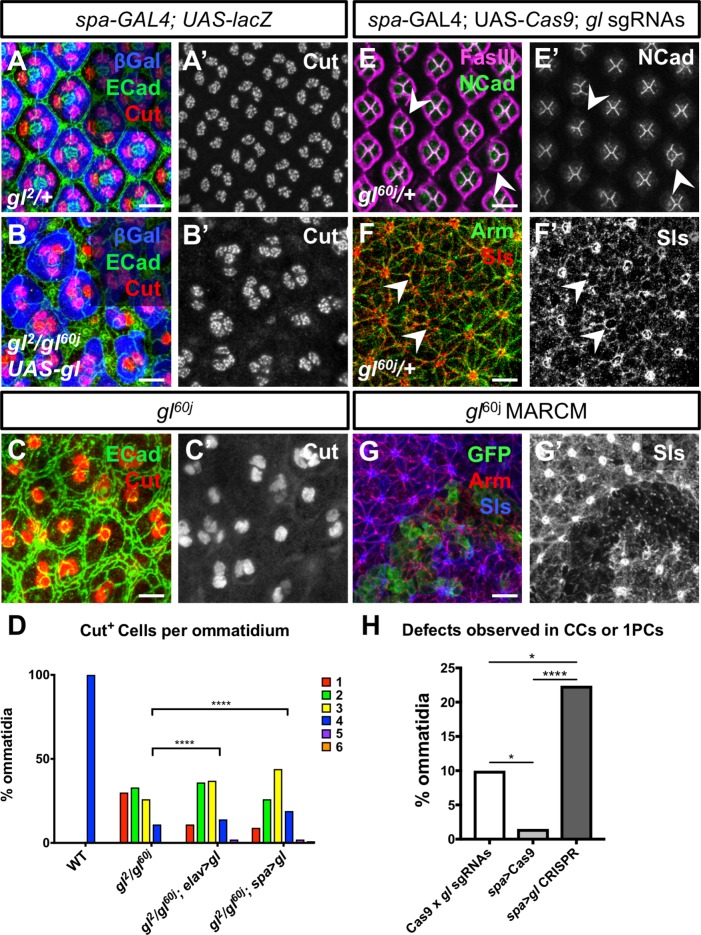
Gl can act autonomously in cone cells.(A-C) 42h APF pupal retinas stained with anti-Ecad (green), anti-Cut (A’-C’, red in A-C) and anti-β-galactosidase reflecting UAS-lacZ driven by spa-GAL4 (blue in A, B). (A) spa-GAL4; UAS-gl; gl/+. (B) spa-GAL4; UAS-gl; gl2/gl60j. (C) gl60j. Expressing Gl in cone cells in a gl mutant background increases the number of cone cells per ommatidium and makes their arrangement more regular. (D) quantification of cone cell numbers in wild type, gl mutant and gl mutant rescued with elav-GAL4, UAS-gl or spa-GAL4, UAS-gl. n indicates number of ommatidia: wild type n = 82, gl2/gl60j n = 79, elav>gl n = 83, spa>gl n = 226. ****p<0.0001, chi-squared test. (E, F) 42h APF gl/+ retinas expressing gl sgRNAs and UAS-Cas9 driven by spa-GAL4 and stained with anti-FasIII (magenta in E) and anti-Ncad to mark cone cell contacts (E’, green in E) or anti-Arm to mark cell outlines (green in F) and anti-Sls (F’, red in F). Mutating gl in cone cells can cause defects in their patterning (E) and loss of Sls in cone cell feet (F, arrows). Some staining is still visible in the photoreceptor axons that surround the cone cell feet. (G) 42 h APF retinas with GFP-labeled gl60j homozygous mutant clones. Retinas are stained with anti-GFP (green), anti-Arm (red) and anti-Sls (G’, blue in G). Sls is strongly expressed in cone cell feet and is lost in gl60j clones. (H) quantification of patterning defects due to loss of Gl in cone cells and primary pigment cells (n = 143), compared to controls in which UAS-Cas9 and gl sgRNAs are present without a GAL4 driver (n = 295) or Cas9 is expressed in the absence of gl sgRNAs (n = 198). ****p<0.0001, *p<0.05, Fisher’s exact test. Scale bars: 10μm.